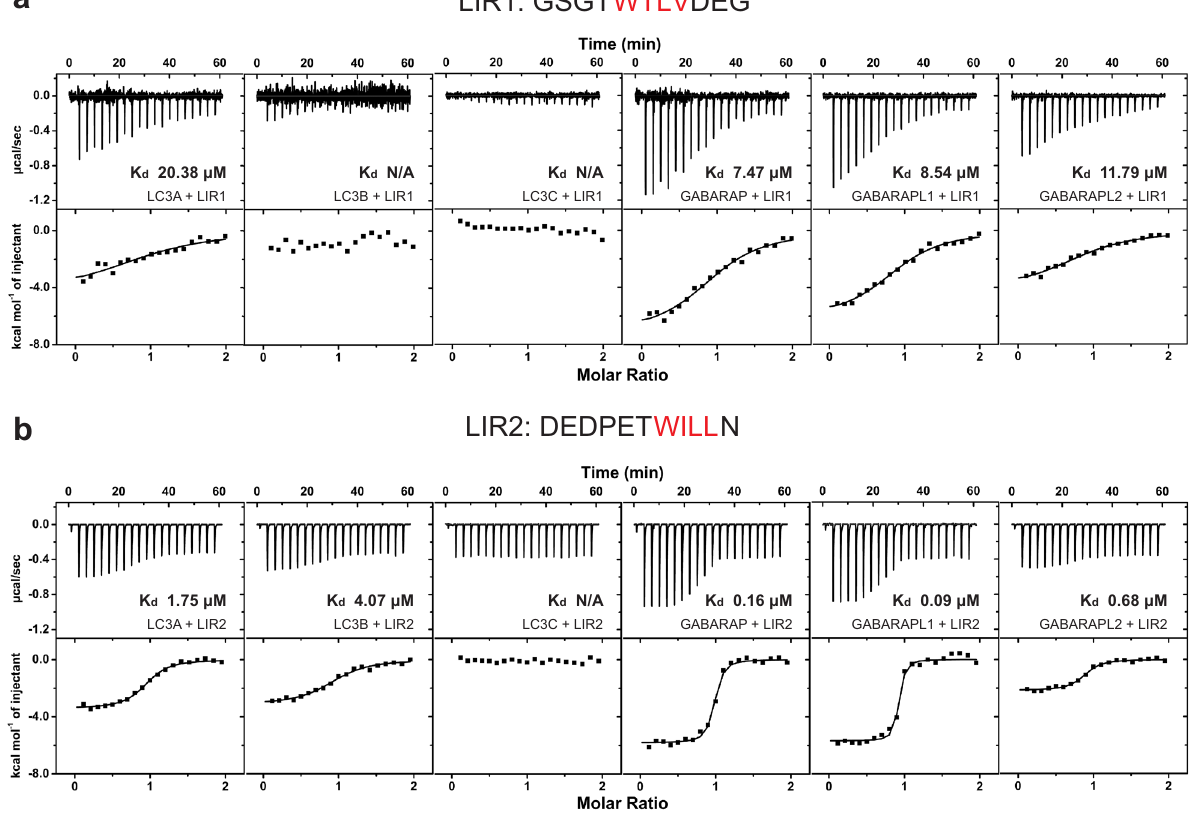
Fig. 3 Isothermal titration calorimetry analysis of hEPG5 LIR motifs with LC3/GABARAP subfamily proteins. a , b Isothermal titration calorimetry (ITC) results of LIR1 peptide ( 546 GSGTWTLVDEG 556 ) (600 µ M) ( a ), and LIR2 peptide ( 560 DEDPETSWILLN 571 ) (600 µ M) ( b ) titrating into individual LC3/ GABARAP subfamily proteins (60 µ M). The top diagram in each ITC plot shows the raw data and the bottom diagram shows the integrated data. Table 1 Data collection and re fi nement